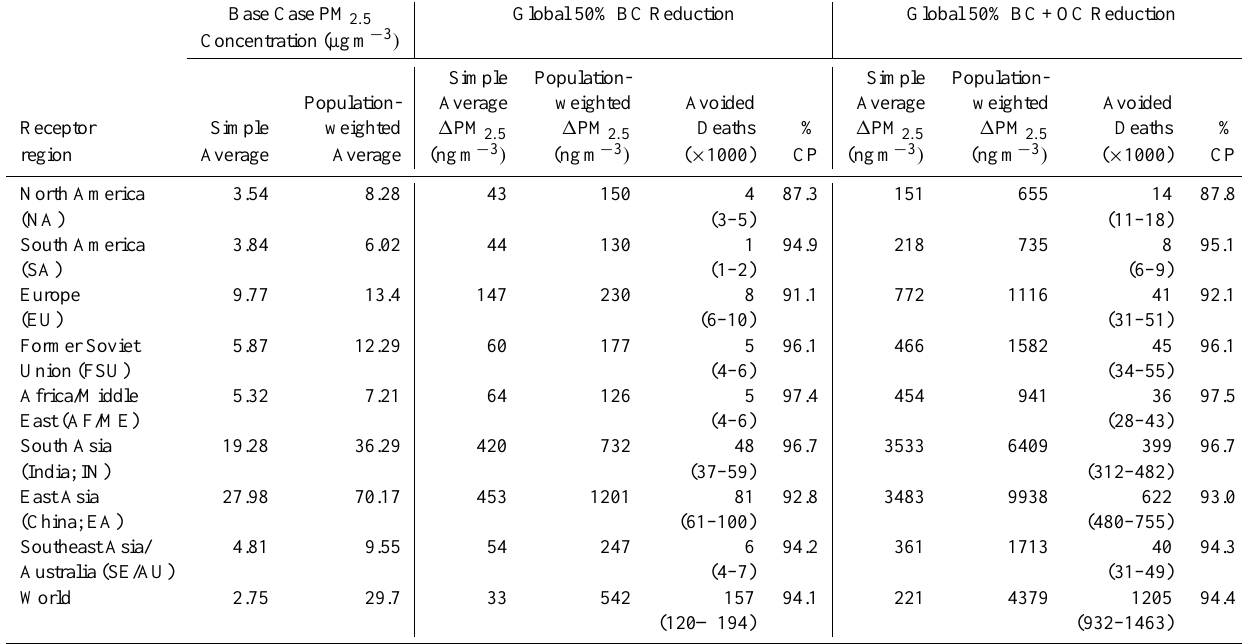
Table 1. Simple and population-weighted annual average PM 2 . 5 (ngm − 3 ) concentrations for the base case and PM 2 . 5 reduction, avoided cardiopulmonary and lung cancer deaths (in thousands), and percent of these deaths from cardiopulmonary (CP) disease due to halving global anthropogenic BC emissions and BC+OC emissions. Confidence intervals (95%, in parentheses) reflect uncertainty in the CRF